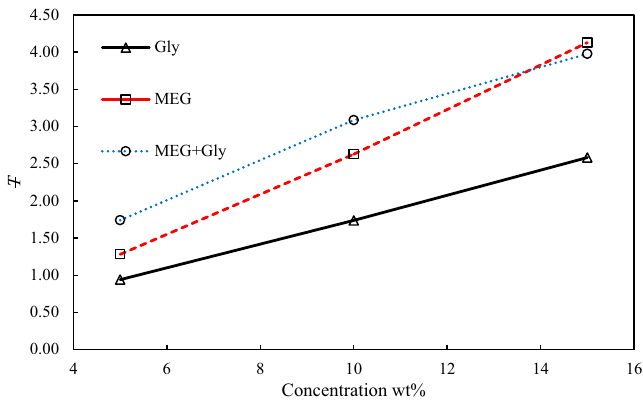
Figure 3. Comparison of average reduced temperature in the presence of THI